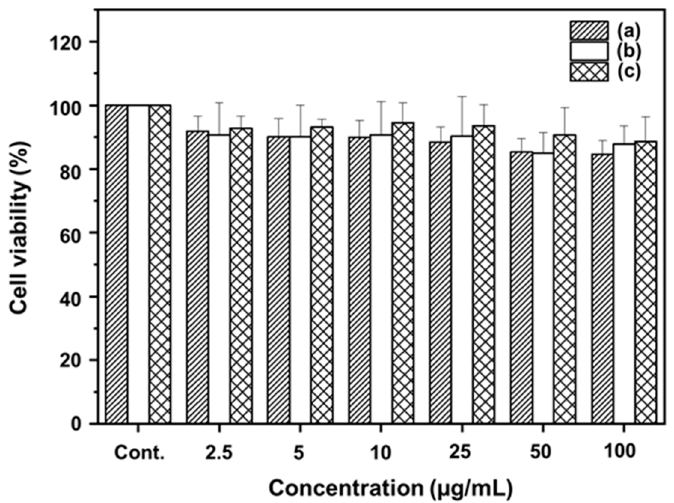
Figure 4 . MTT assay of L929 cells following 24 h of treatment with ( a ) NA, ( b ) pristine LDH, and ( c ) (c) NA-LDH .